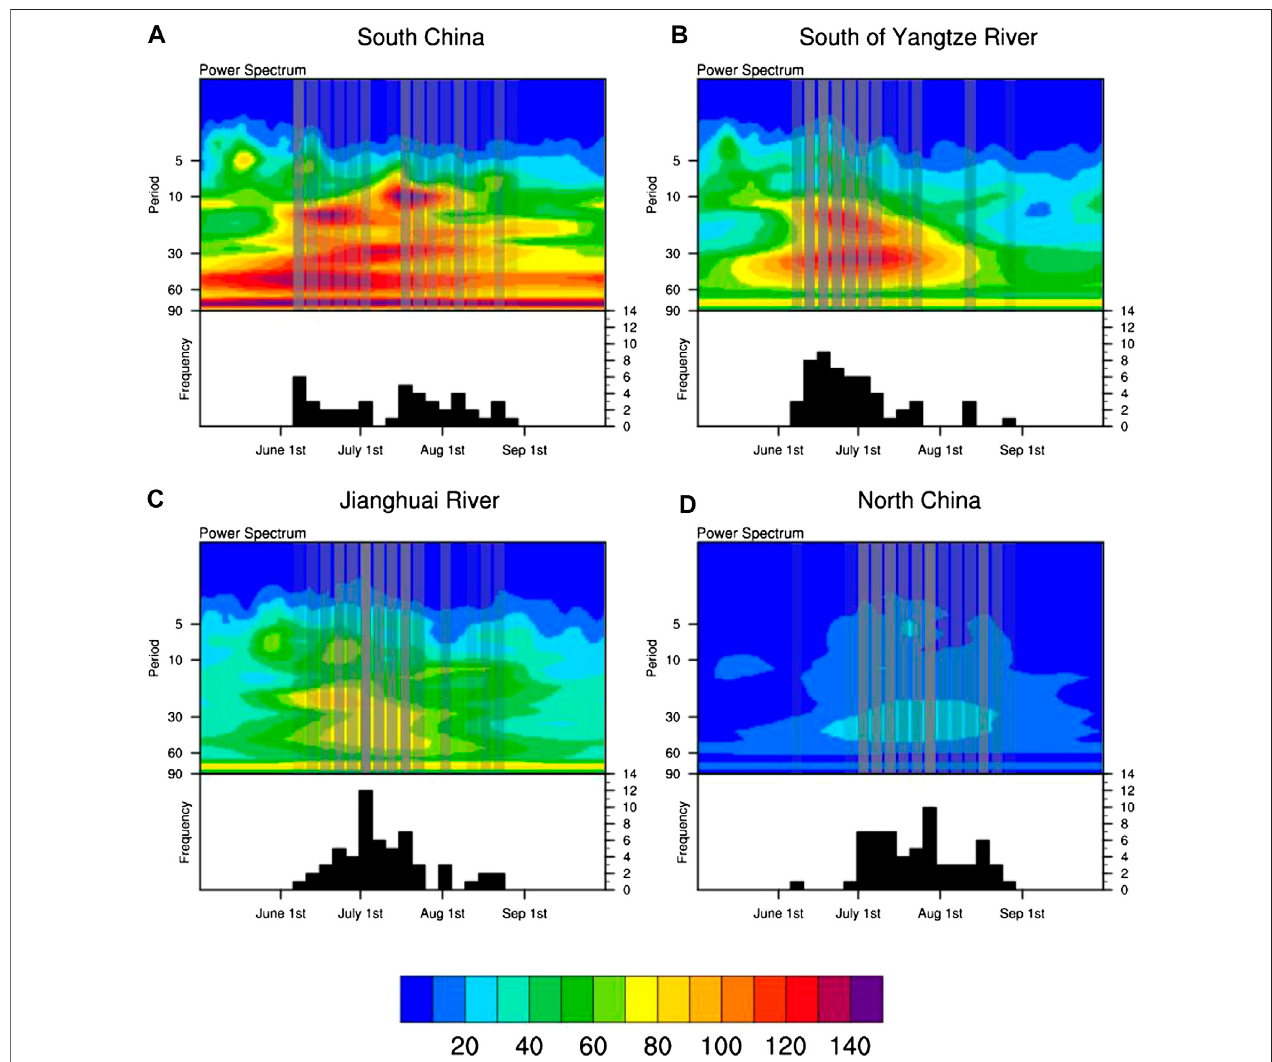
FIGURE 8 | The composite wavelet analysis of area-averaged precipitation during the period from May 1st to September 30th and the frequency of RPEP during summerforRPEPyearsinSC (A) ,SYR (B) ,JHR (C), andNC (D) .ThegraythicklinerepresentstheoccurrenceofRPEP,andthedarkerthegraylineis,themoreRPEPs occur in the speci fi c